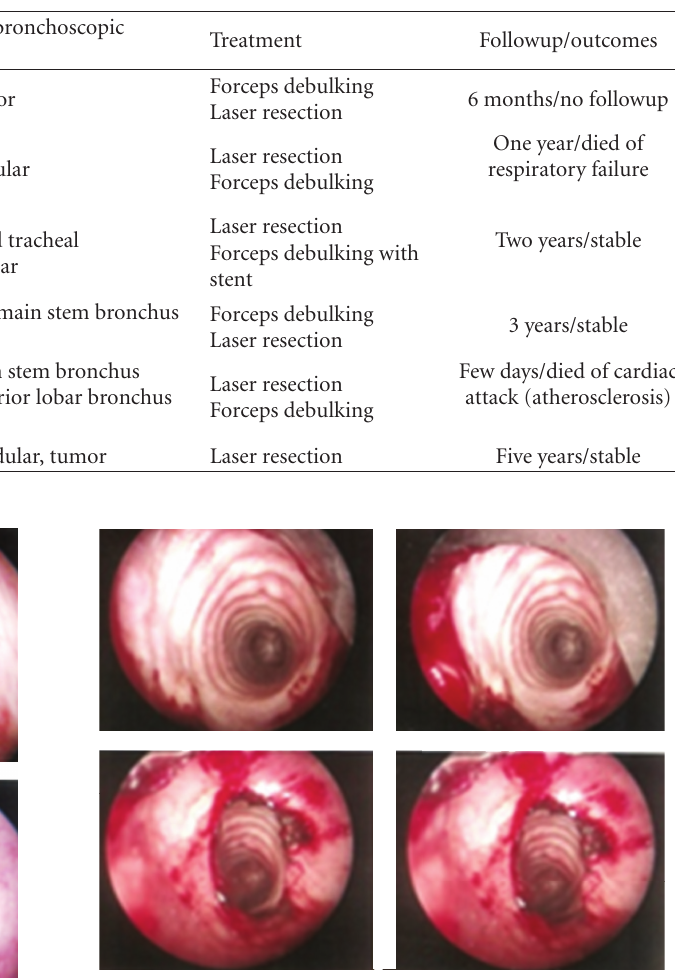
Table 1: Characteristics of six patients with tracheobronchial amyloidosis.